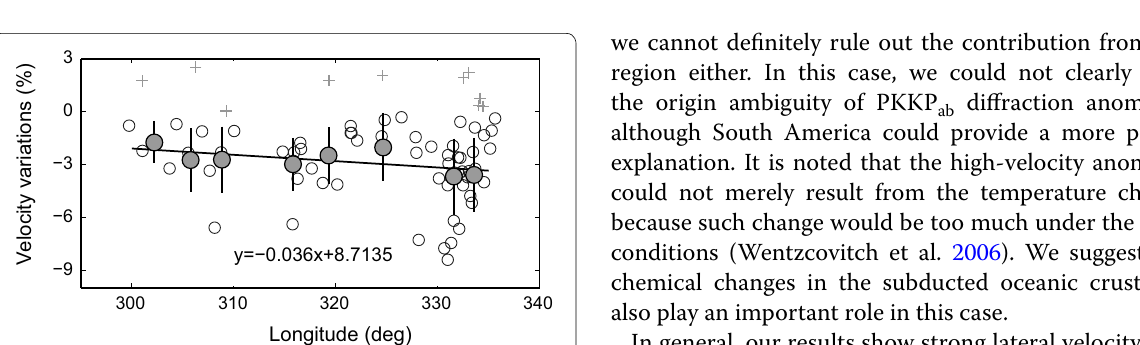
the north of South America a good place for these het- erogeneities. However, in the corresponding source side beneath southern Sumatra Islands, the high velocities are located on both sides of the slow anomaly, which